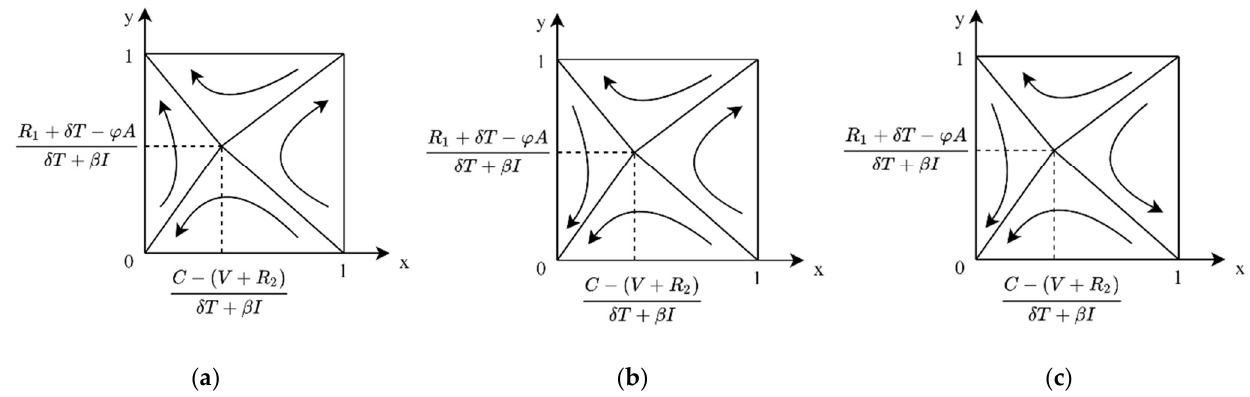
Figure 2. Evolutionary phase diagram of government cost–benefit under R 1 + δ T < ϕ A . ( a ) When R&D costs are relatively low. ( b ) When R&D costs are somewhat high. ( c ) When R&D costs are high.